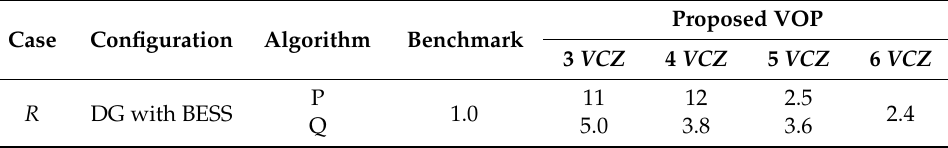
Table 10. Normalized objective functions (p.u.) for Case R —DG and BESS.